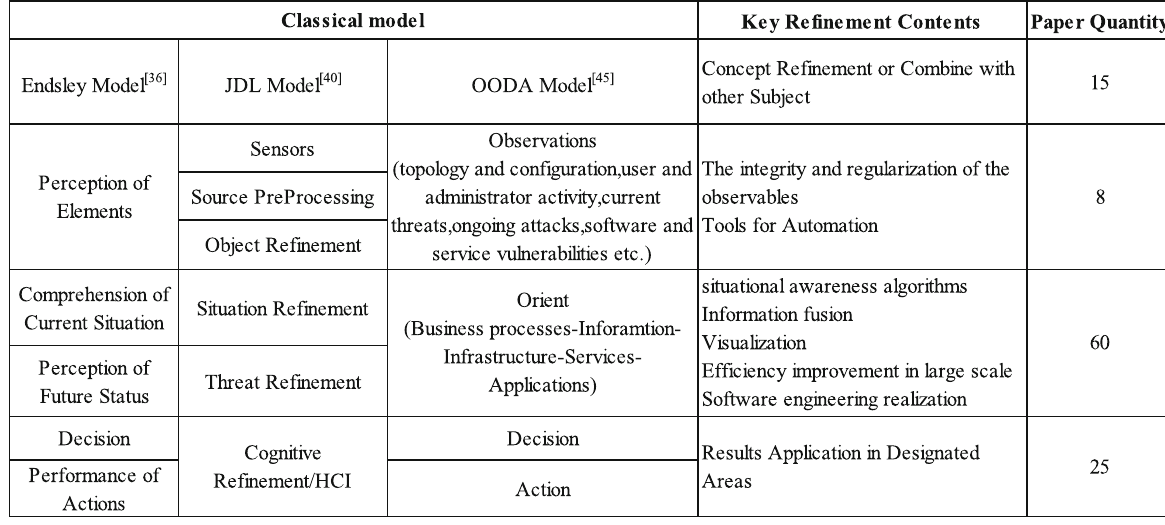
Table 3 A statistical classification summary of 75 foreign languages based on literature